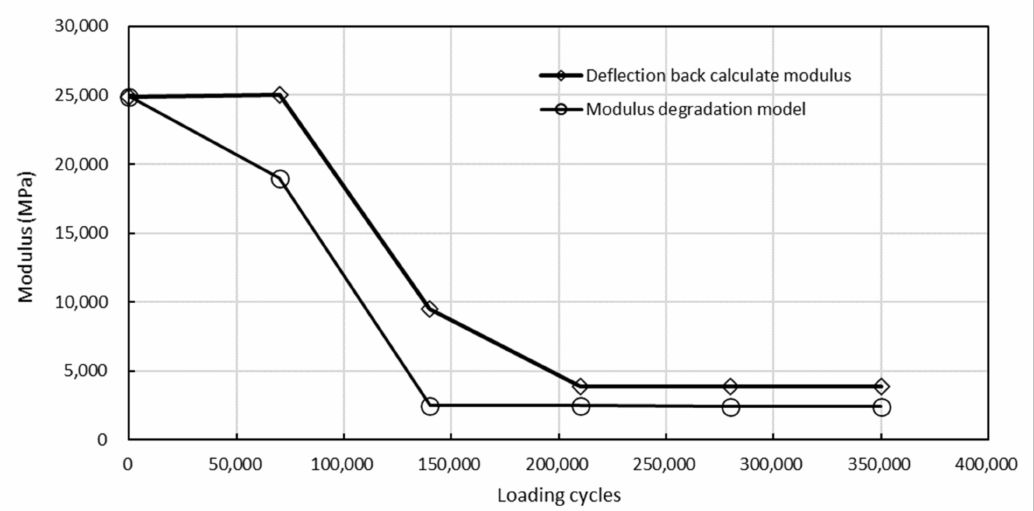
Figure 17. The modulus of deflection back calculation and degradation model in Structure 2.